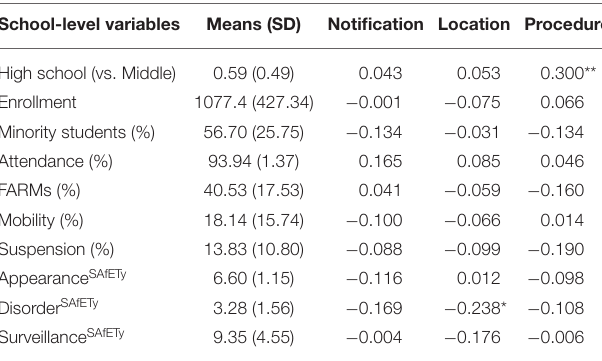
TABLE 1 | School-level demographics and correlations between school-level and the three crisis